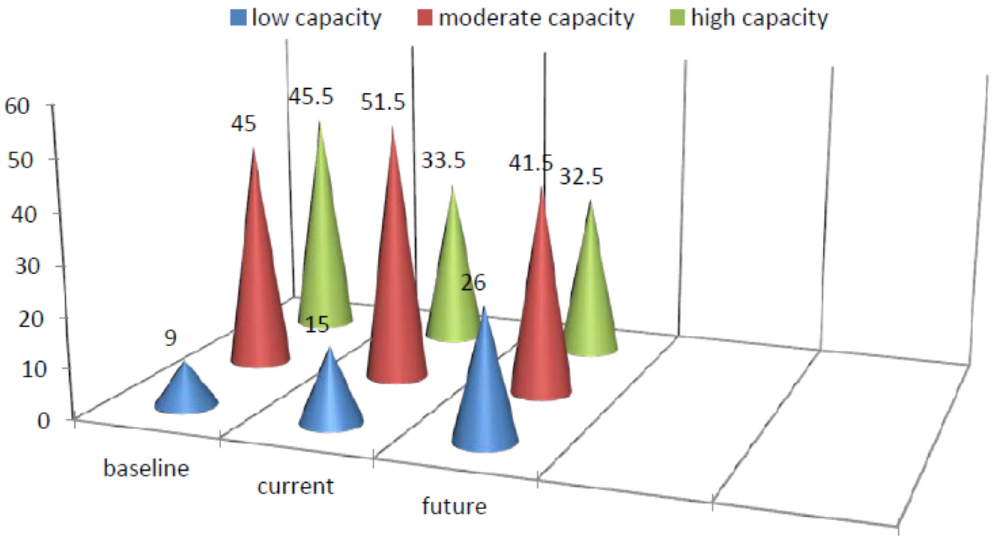
Figure 7. Percentage of the landscape with different relative capacities (low, moderate, and high) for multiple ES supply under each of past, present, and possible future conditions.